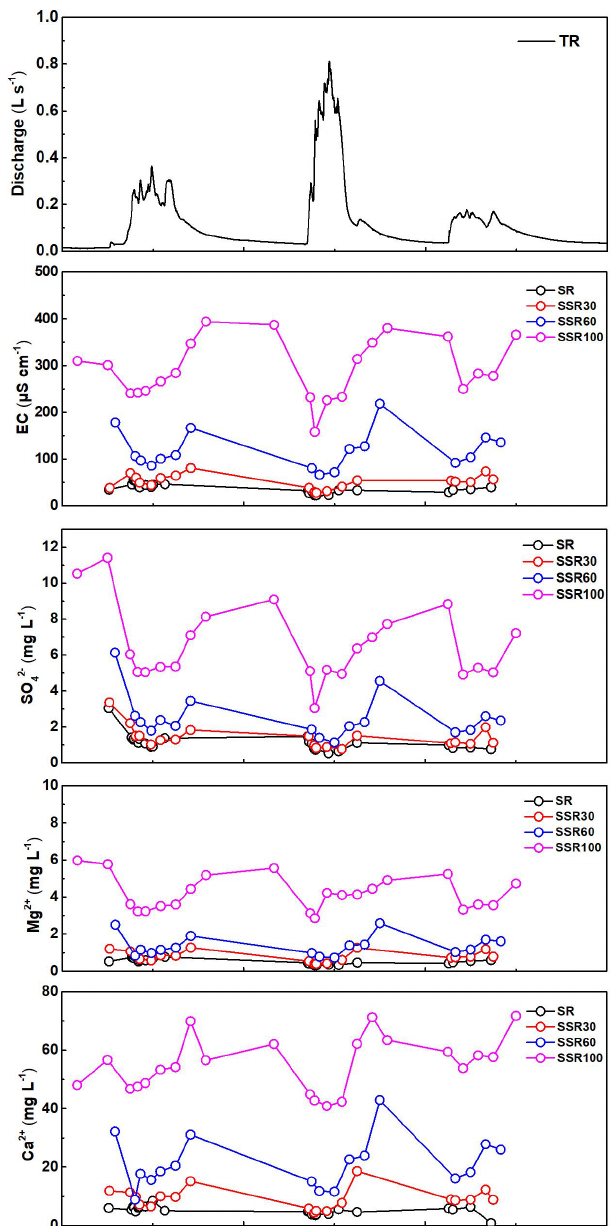
− , Mg 2 + and Ca 2 + in different 4